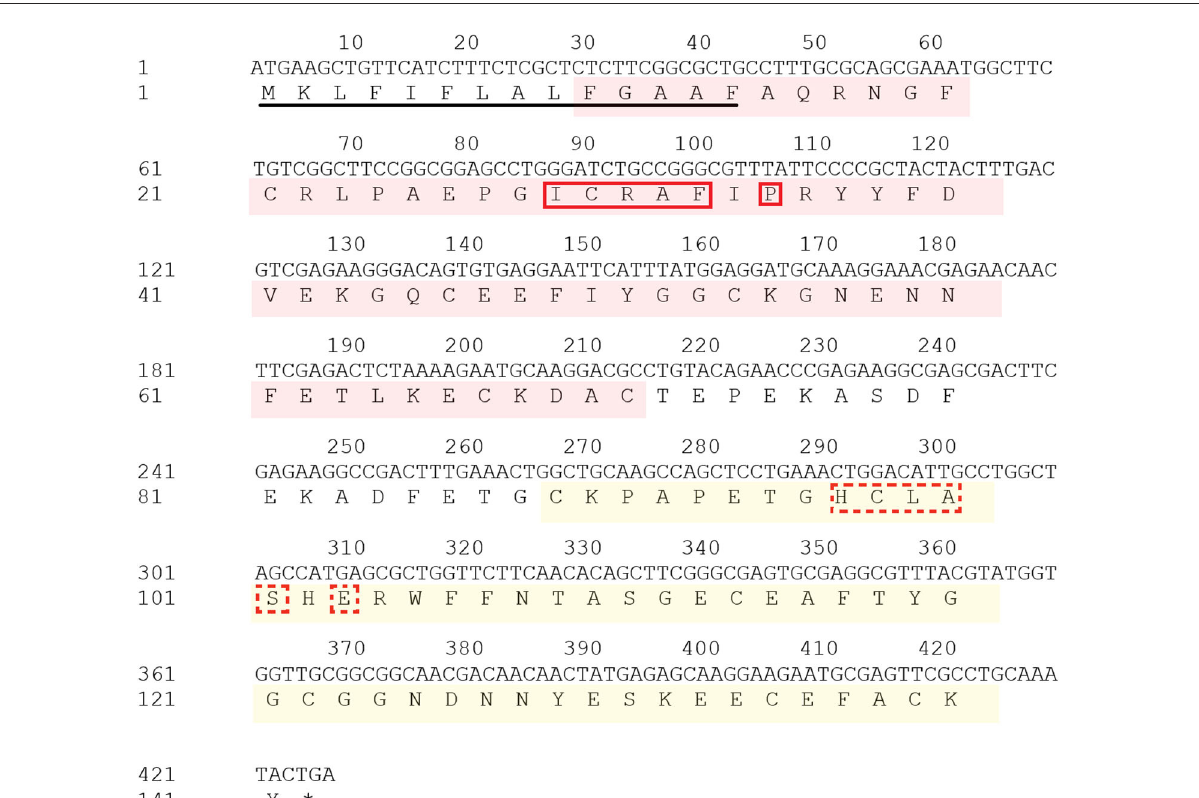
FIGURE1 Nucleotide sequence and deduced amino acid sequence of Doenitin-1 . Row 1: Number position, which is counted every 10 bases. Row 2: Nucleotide sequence. Row 3: Amino acid sequence. The red area is the BPTI/Kunitz family of serine protease inhibitor domain; the yellow area is the Kunitz/Bovine pancreatic trypsin inhibitor domain; signal peptides are underlined; the solid red box is the BPTI/Kunitz binding presenting loop; the red dotted box is the Kunitz/Bovine pancreatic trypsin binding presenting loop. Both domains belong to the BPTI/Kunitz family of serine protease